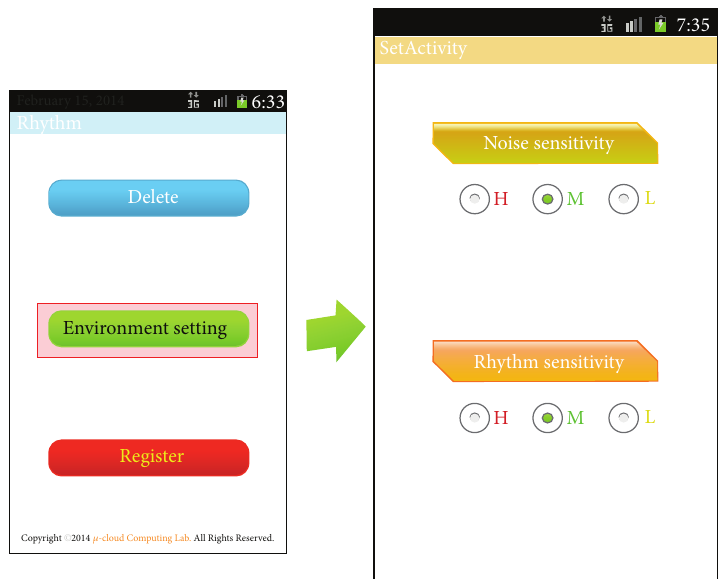
Figure 6: Screen of noise and rhythm setup for the RLS.